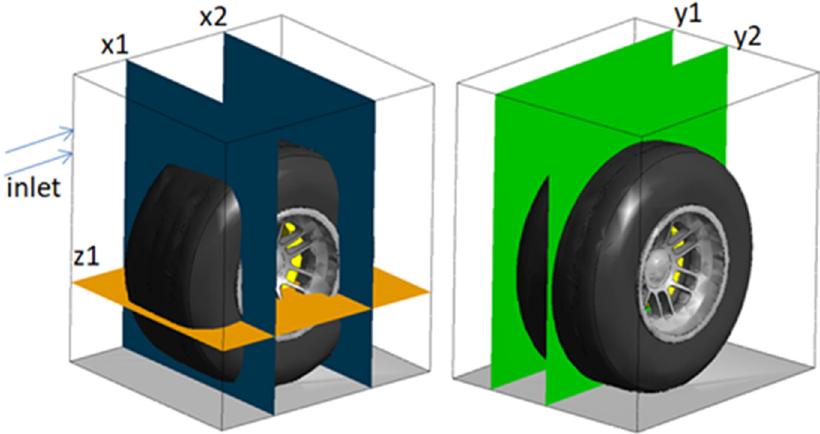
Figure 6. Control plans for post-processing.